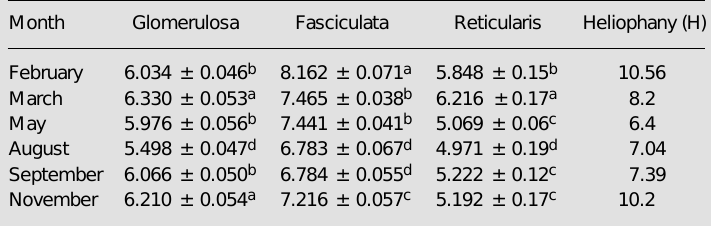
Table 3 - Seasonal variation of nuclear volume in adrenal cortex of viscacha.